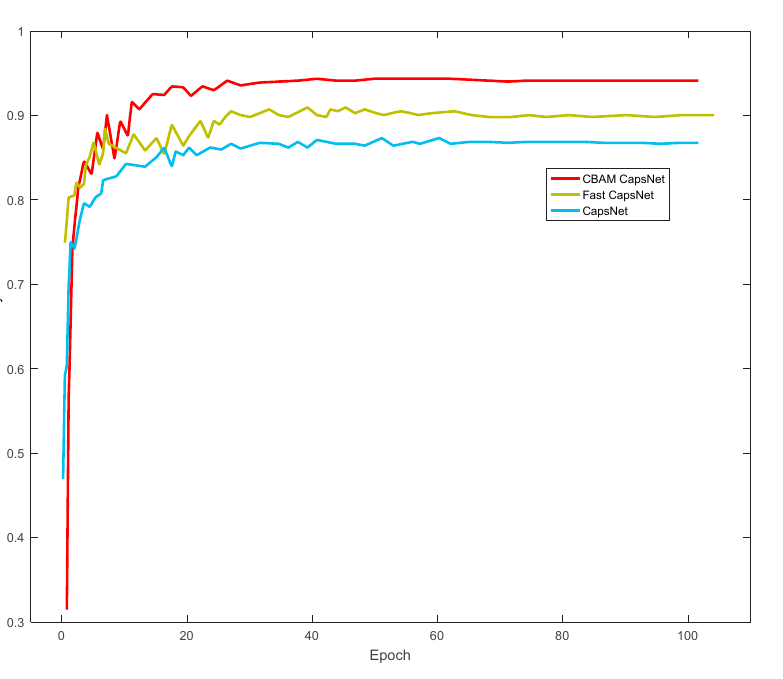
Figure 9. The relationship between the accuracy and epochs.